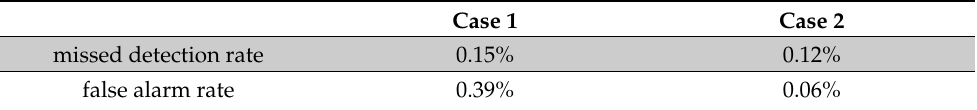
Table 3. Missed detection and false alarm rate for the discriminant sea-ice flag in the test data set (Table 1). Only observations within the a-priori sea-ice flagging (Section 2.1.6) are considered